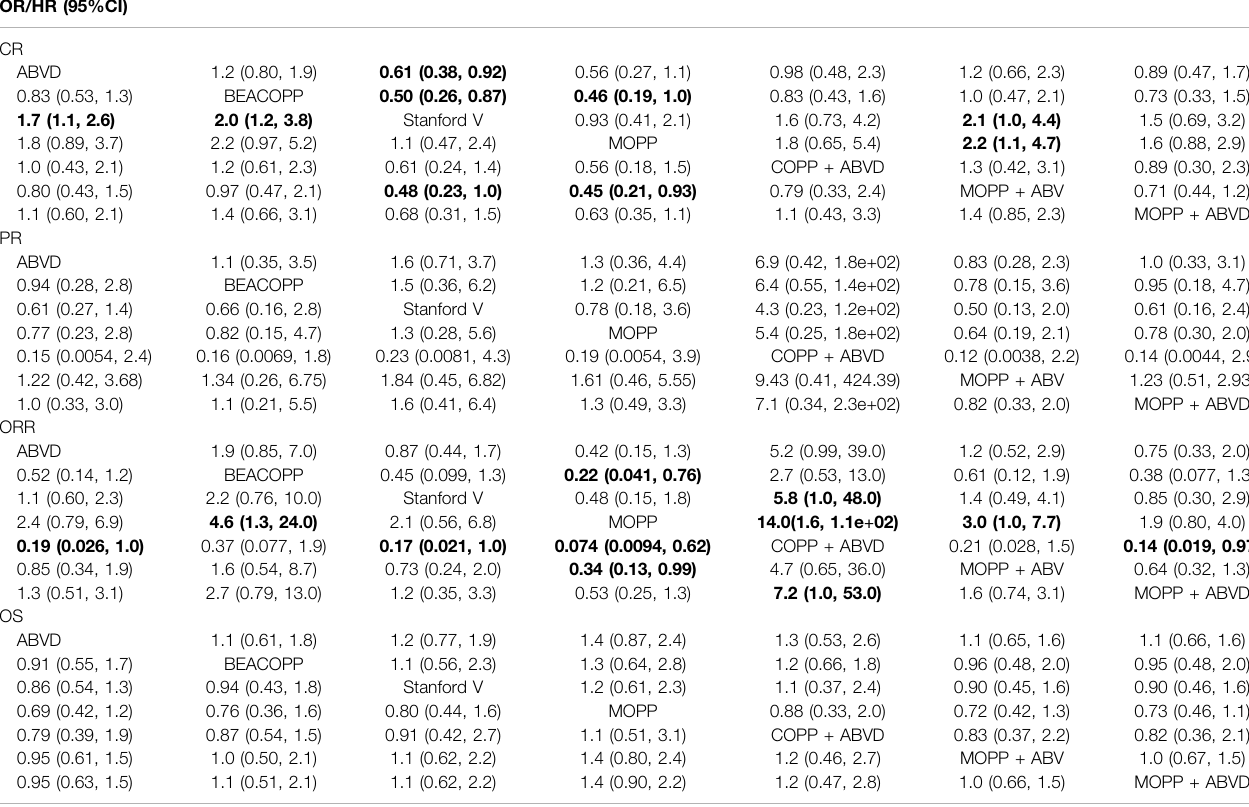
TABLE 3 | OR (95%CI) of seven treatment modalities of three endpoints for ef fi cacy in Hodgkin lymphoma. OR/HR (95%CI) CR